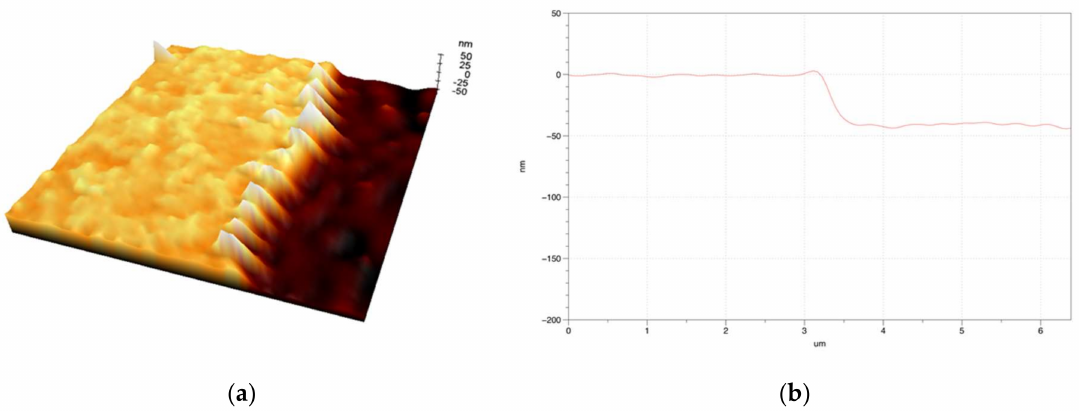
Figure 7. Three-dimensional morphology image ( a ) and cross-sectional graph obtained at the ablation edge using the AFM after one pulse irradiation ( b